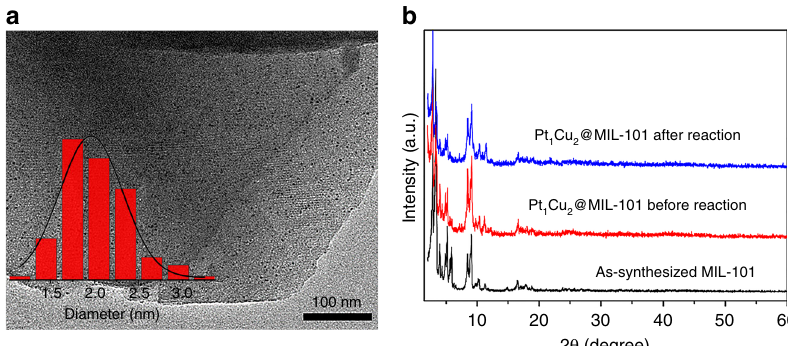
Fig. 6 TEM image and PXRD patterns. a The TEM image and (inset) the corresponding size distribution of PtCu NPs in Pt 1 Cu 2 @MIL-101 after three catalytic cycles. b Wide-angle PXRD patterns of MIL-101 and Pt 1 Cu 2 @MIL-101 before and after catalytic reaction NATURE COMMUNICATIONS| (2019) 10:3462